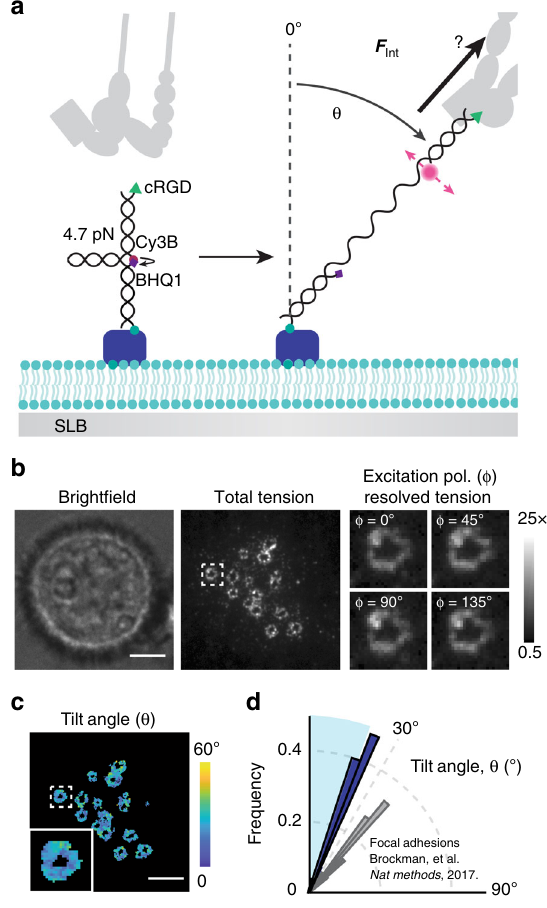
Fig. 3 Integrins exert vertical forces in podosome rings. a Schematic of MFM on an SLB. When an integrin receptor binds and applies forces above 4.7 pN, the probe unfolds and generates Cy3B fl uorescence. Probes orient along the applied force vector, allowing determination of the tilt angle, θ , from the excitation polarization dependent Cy3B fl uorescence. b Representative podosome MFM data after ~90 min cell spreading. Total tension is the maximum tension signal per pixel. Podosome zoom-ins depict the normalized Cy3B fl uorescence at four different excitation polarizations. Scale bar, 5 µ m. c Computed tilt angle map for the cell shown in b . Scale bar, 5 µ m. d Angular histogram of average podosome tilt angle per cell, θ . Vertical forces are indistinguishable within the ~20° cone, represented by the blue region ( N = 25, three experiments). Source data are provided as a Source Data fi